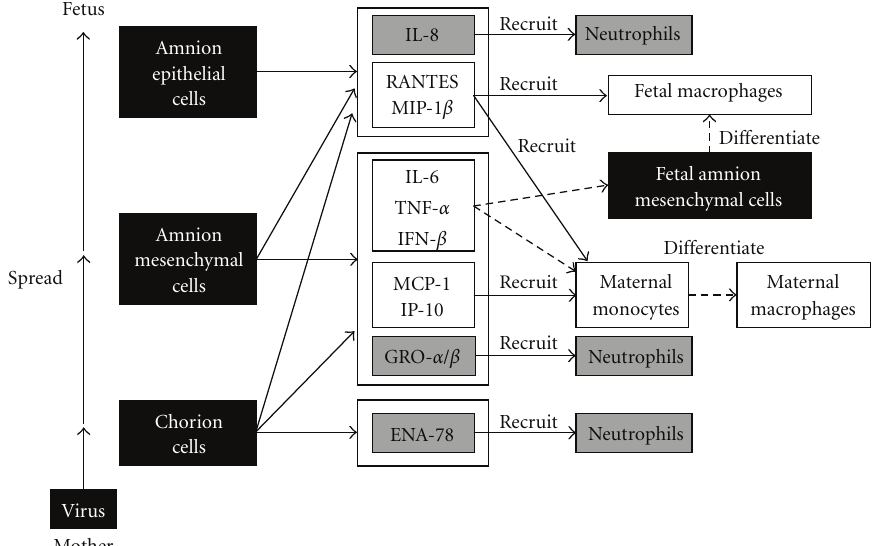
Figure 6: Multistage roles of chemoattractive cytokines and MDI factor produced by chorion, amnion mesenchymal, and amnion epithelial cells in the recruitment and di ff erentiation of phagocytes. When influenza viruses spread from mother to the chorion cell layer at the first stratum, ENA-78, GRO- α / β , and IL-8 may be firstly produced to recruit a first unit of neutrophils by only chorion cells that are located on the maternal-fetal interface. The chorion cells may produce MCP-1, IP-10, RANTES, and MIP-1 β to recruit maternal circulating monocyte, IL-6, TNF- α , and IFN- β to di ff erentiate the recruited maternal monocytes, and the staying fetal amnion mesenchymal cells to macrophages. When the viruses got over the chorion cell layer and spread to the amnion mesenchymal cell layer at the second stratum, the amnion mesenchymal cells may produce GRO- α / β and IL-8 to recruit a second unit of neutrophils as reinforcements, MCP-1, IP-10, RANTES, and MIP-1 β to recruit maternal circulating monocytes, and IL-6, TNF- α and IFN- β to di ff erentiate the recruited maternal monocytes and the staying fetal amnion mesenchymal cells to macrophages as well as the chorion cells. If the virus spread to the amnion epithelium as a final cellular barrier, the amnion epithelial cells may produce IL-8 to recruit a third unit of neutrophils and RANTES and MIP-1 β to recruit fetus-derived macrophages di ff erentiated from the staying amnion mesenchymal cells. Abbreviations used: ENA-78, epithelial cell-derived neutrophil-activating protein 78; GRO- α / β , growth-related oncogene α / β ; IL, interleukin; IP-10, interferon inducible protein 10; MCP-1, monocyte chemoattractant protein 1; MDI, monocyte di ff erentiation-inducing; MIP-1 β , macrophage inflammatory protein 1 β ; RANTES, regulated on activation, normal T cell expressed and